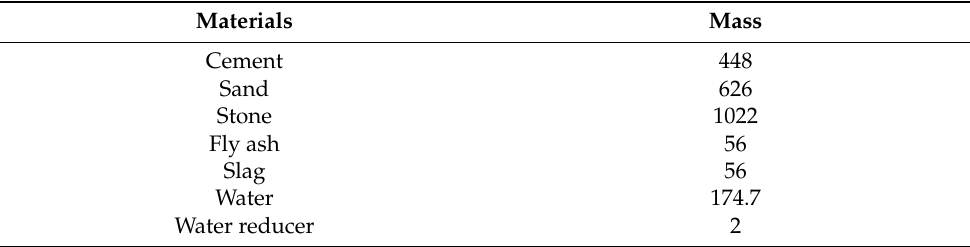
Table 4. Mixture of C60 (kg/m 3 ).